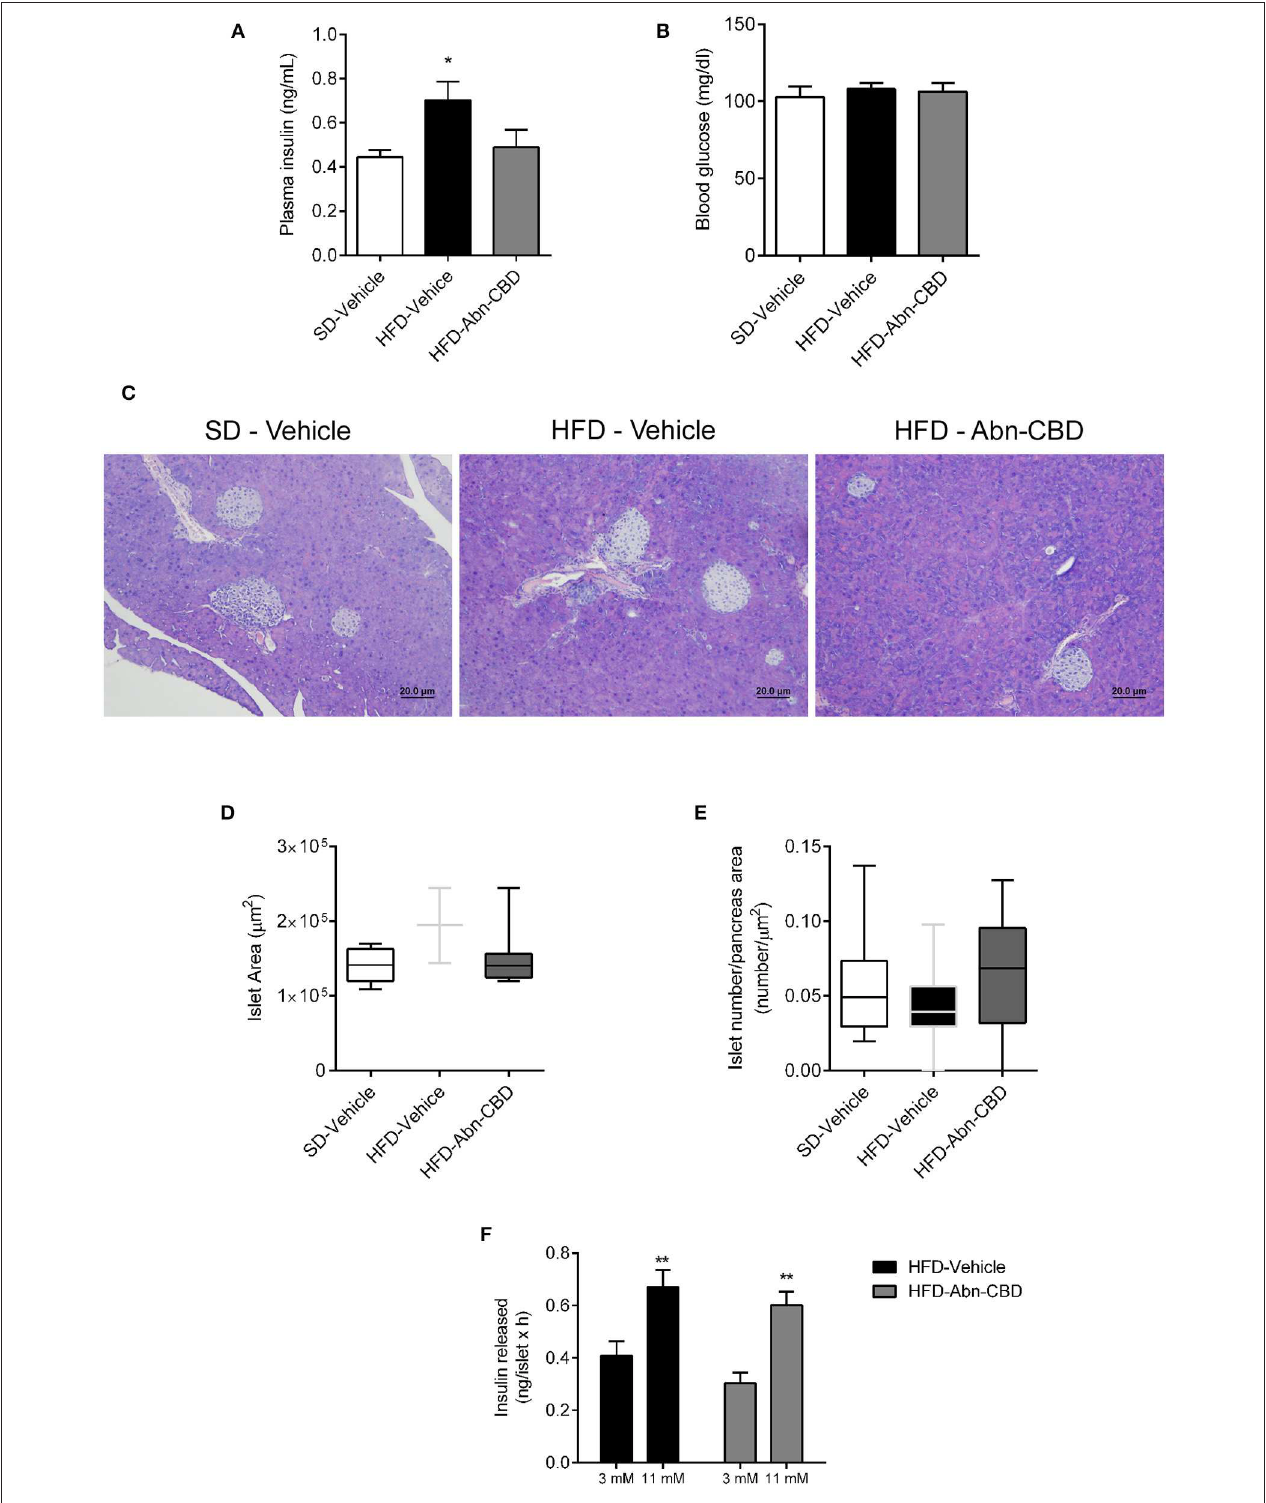
FIGURE 2 | Effect of Abn-CBD on glucose homeostasis, islet morphology and functionality. (A) Fasted (overnight) plasma insulin and (B) blood glucose levels at the end of the study. (C) Representative photomicrographs of islets. (D,E) Morphometric analysis of islets. Data show mean ± S.E.M. except (D,E) that show median ± min to max. n = 6 SD-Vehicle, n = 7 HFD-Vehicle and n = 8 HFD-Abn-CBD except (D) , n = 51–66 islets from 4 mice each group, (E) n = 52–81 islets from 4 mice each group. * p ≤ 0.05 and ** p ≤ 0.01 compared to SD-Vehicle. (F) Static glucose-stimulated insulin secretion in HFD-Vehicle and HFD-Abn-CBD isolated islets. N = 11–12 wells each condition, islets from 2 mice each group.